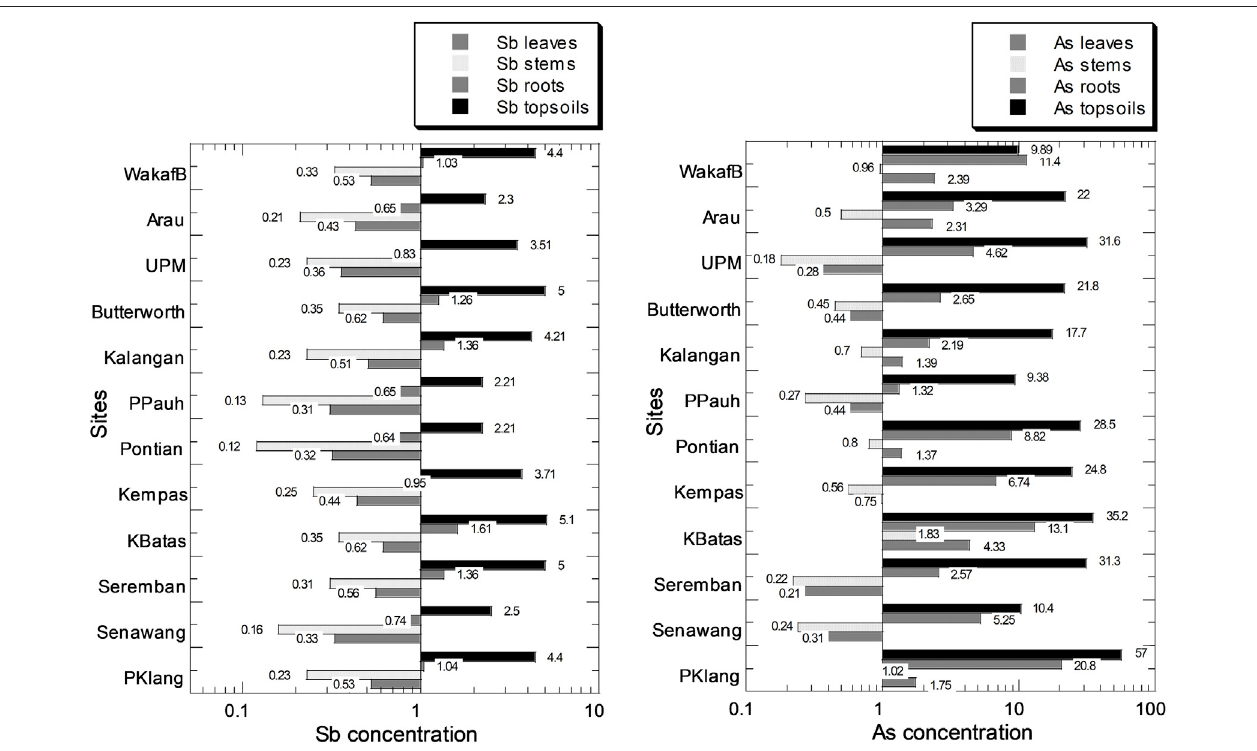
FIGURE 2 | Mean concentrations (mg/kg dry weight) of Sb and As in leaves, stems, and roots of Centella asiatica and their habitat topsoils collected from 12 sampling sites (indicated by numbers in white circles (1 – 12) in Figure 1 ; S1 – S12 in Supplementary Table S1 ) in Peninsular Malaysia. The X -axes are based on a logarithmic